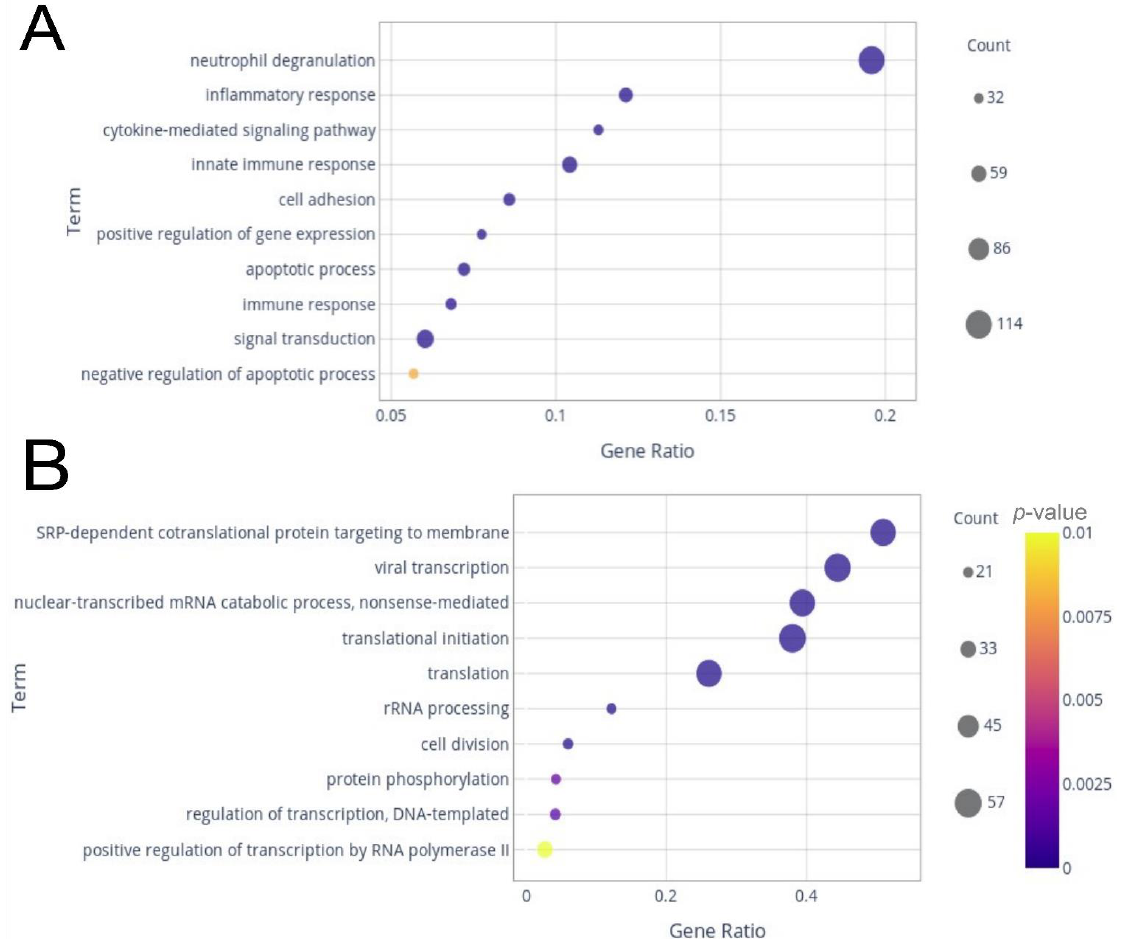
Figure 2. Dot plots from gene ontology biological process enrichment analysis. The plots display the top 10 terms with higher gene counts among up-regulated genes ( A ) and down-regulated genes ( B ).